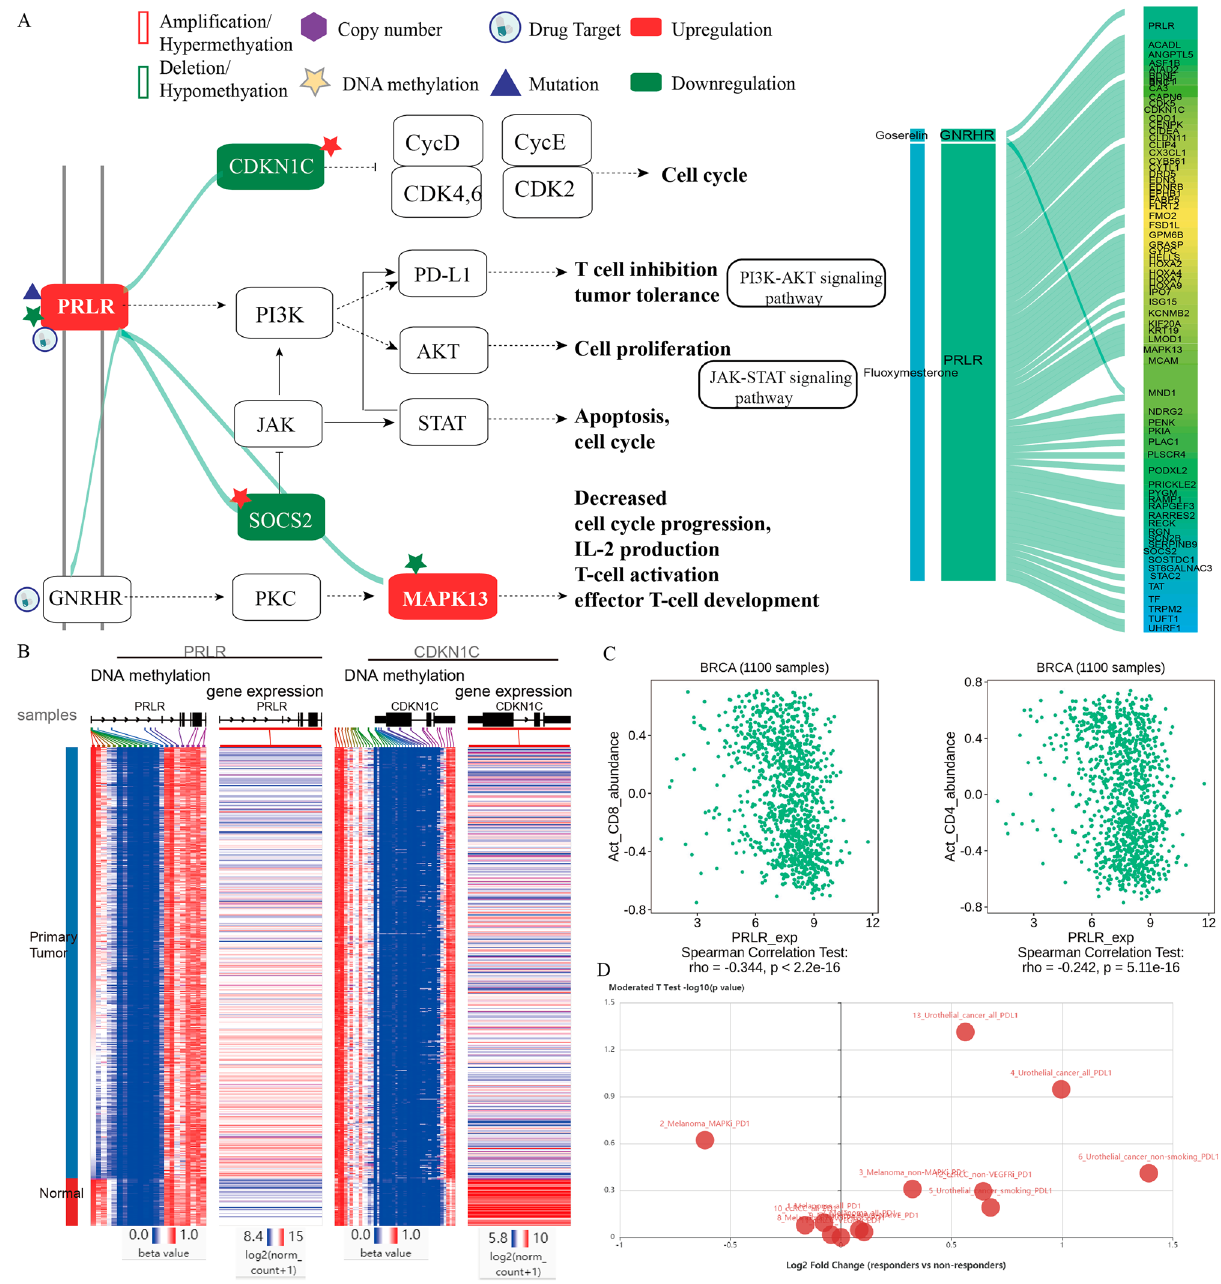
Figure 3. PRLR-associated functional regulations in the methylation alteration-driven network. ( A ) PARP1- associated gene pairs (green line) can regulate cell proliferation, apoptosis, T cell inhibition, and the JAK-STAT and PI3K-AKT signaling pathways 81 . ( B ) Genetic alteration and gene expression alteration of genes using UCSC Xena. ( C ) Spearman’s correlations between of PRLR expression and immune cell levels across human breast cancers. ( D ) Expression differences of PRLR between responders and non-responders to immunotherapy using